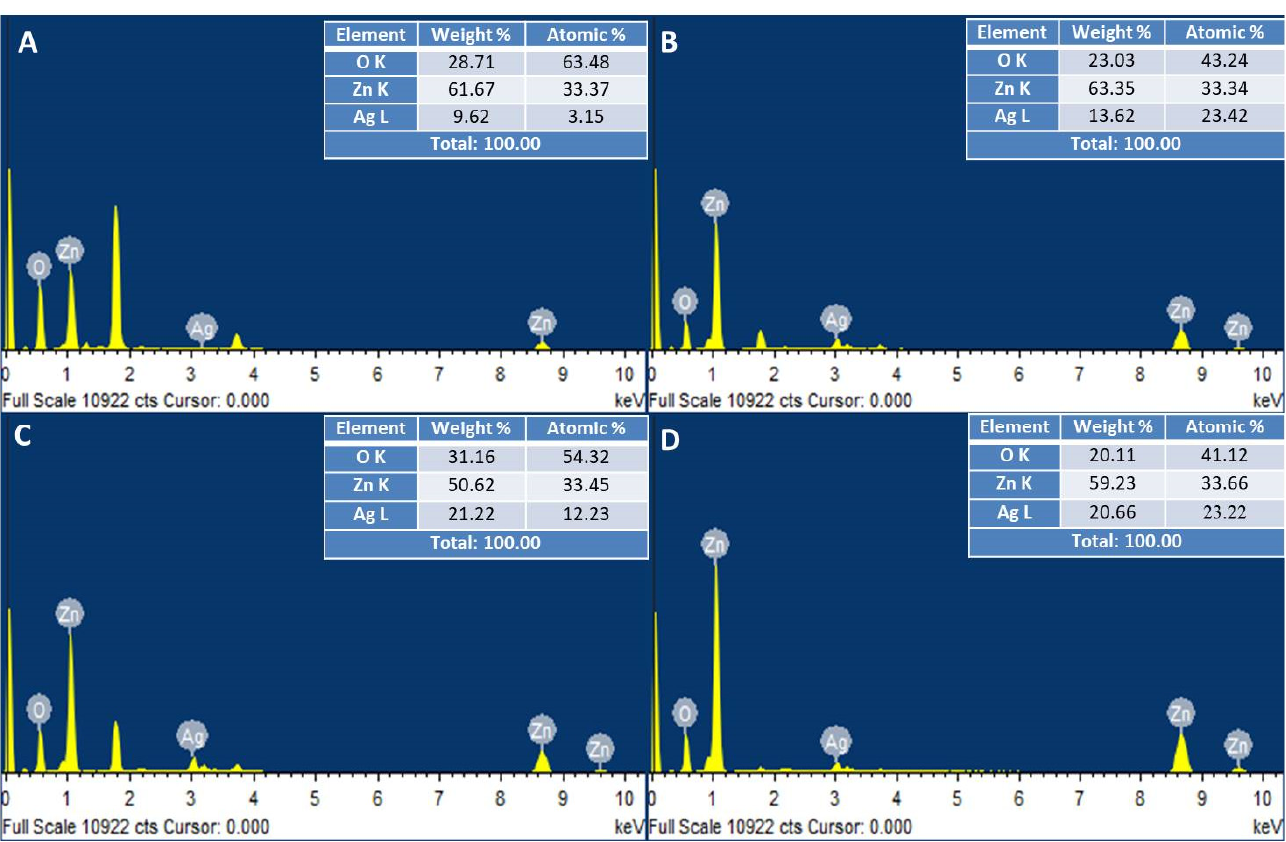
Figure 10. EDX analysis of bimetallic Ag–ZnONPs. ( A ) Control Ag–ZnO (0.1/0.1). ( B ) UV-C mediated Ag–ZnO (0.1/0.1). ( C ) Control Ag–ZnO (0.1/0.5). ( D ) UV-C mediated Ag–ZnO (0.1/0.5).